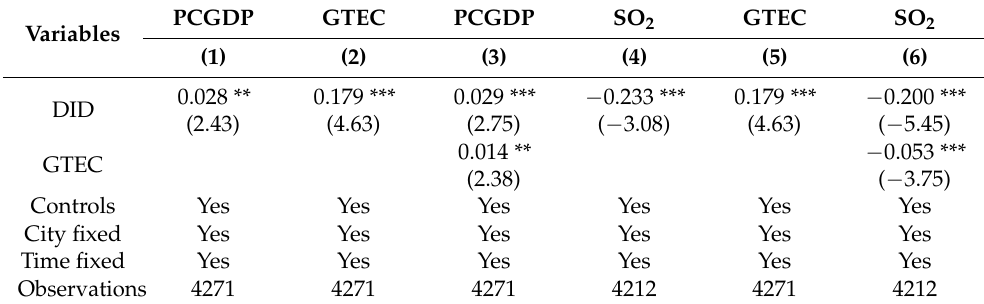
Table 9. Mediating effect of